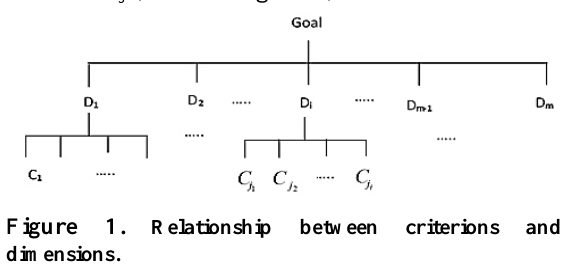
Figure 1. Relationship between criterions and dimensions.